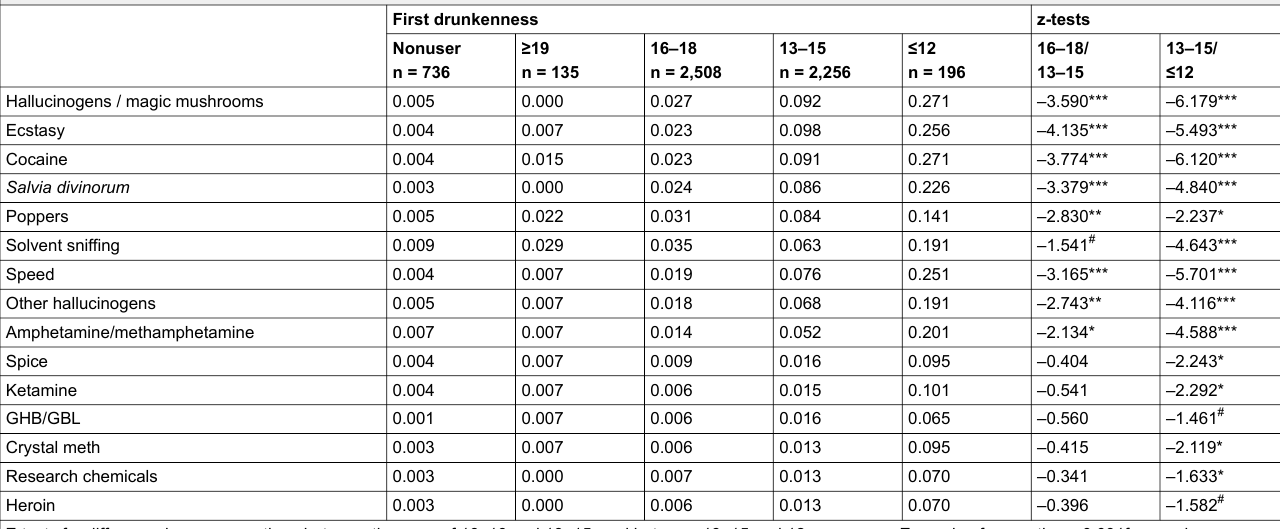
Table 6: Proportion of drug users within age categories for onset of intensive use of alcohol.